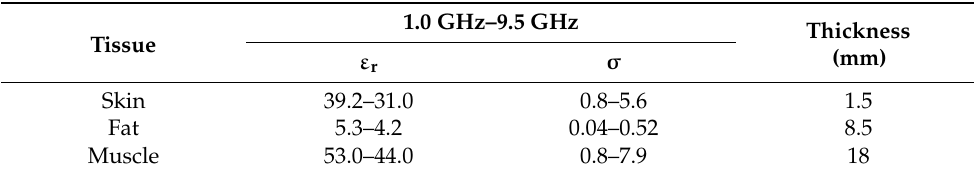
Table 3. Dielectric properties and thickness of human tissue.